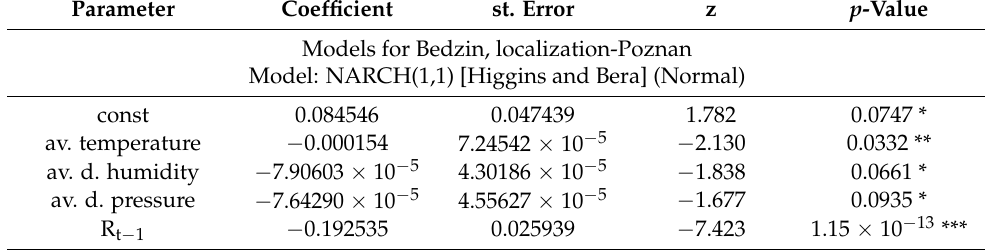
Table 3. Parameter values and a significance level of independent variables for individual companies (dependent variable: R t